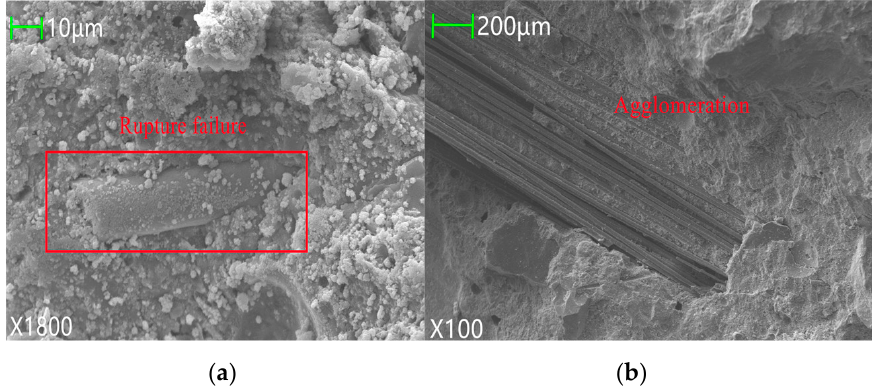
Figure 14. SEM image of BF 5.5 RC and BF 7.5 RC concrete. ( a ) BF 5.5 RC. ( b ) BF 7.5 RC.